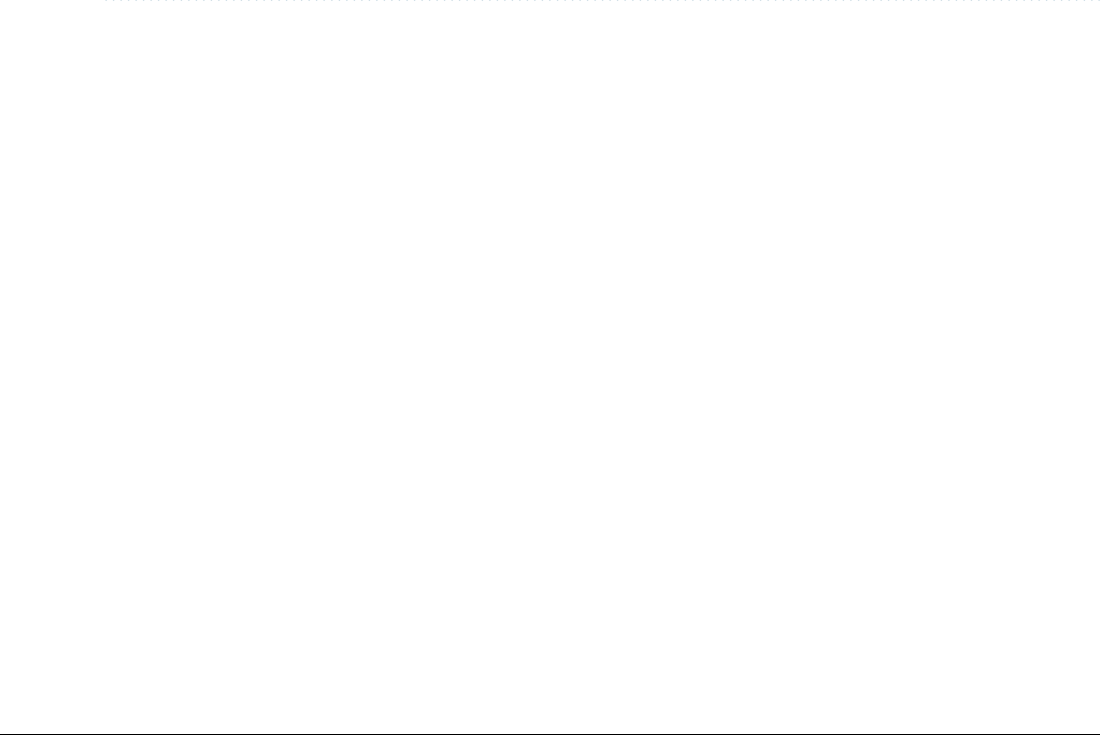
Figure 9. Comparison of velocity profiles. ( a ) For two values of Gm . ( b ) For two values of (cid:31) 1 . ( c ) For two values of Q